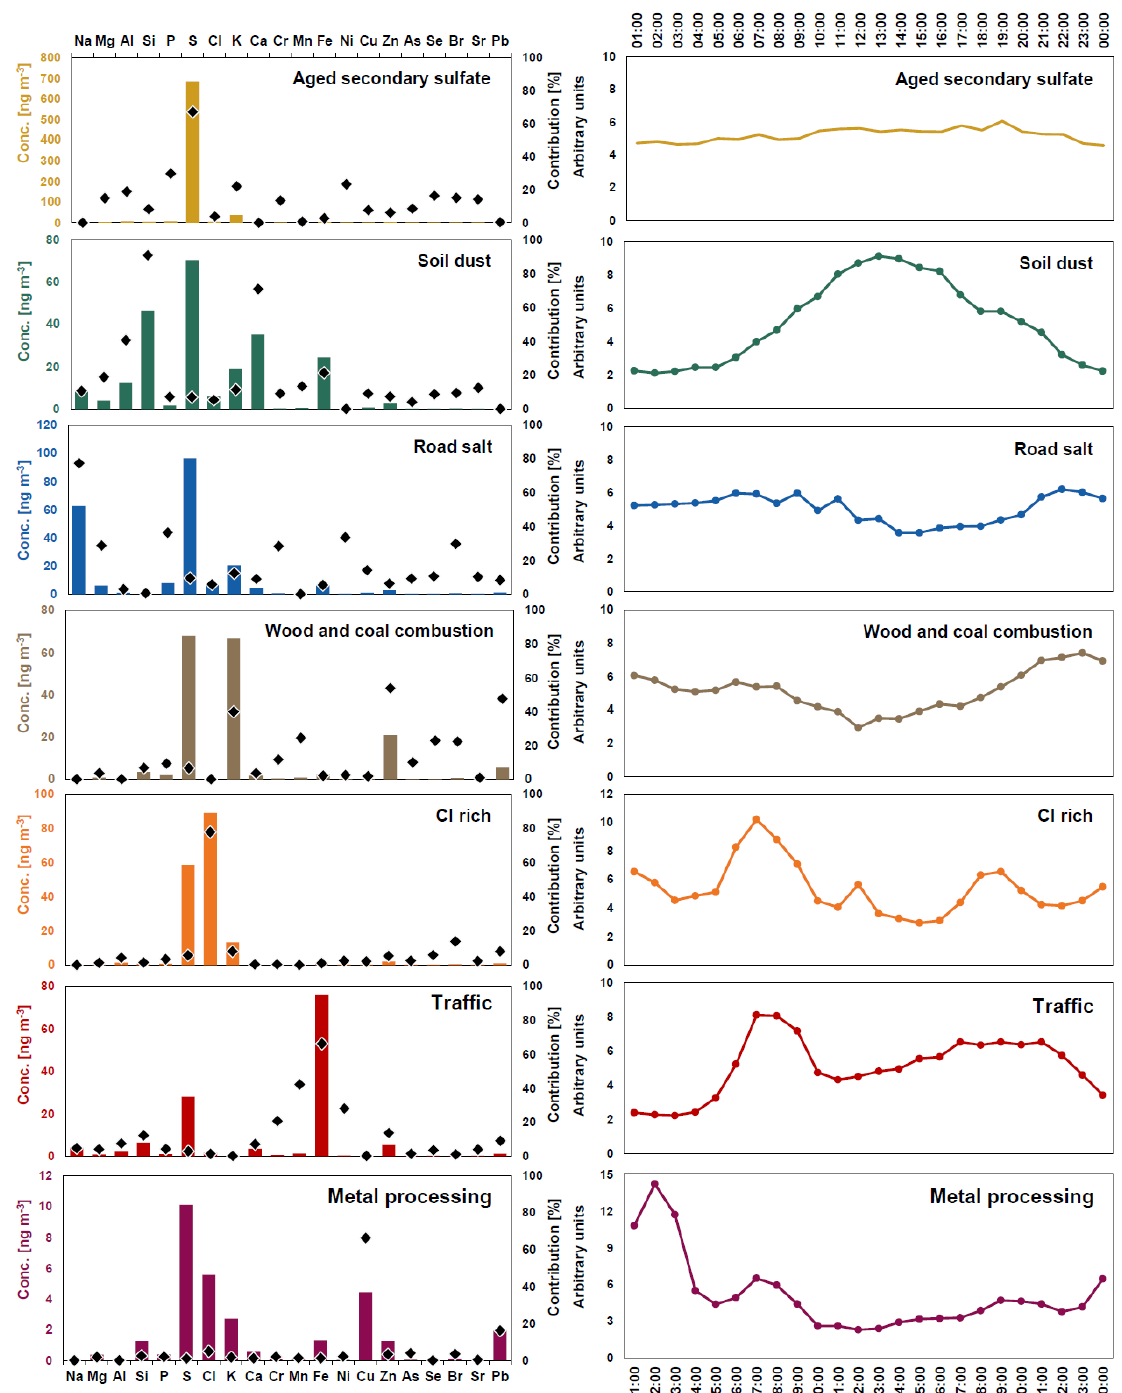
Figure 4. The left column shows the PMF profiles (bars; left y axis) and contributions (black diamonds; right y axis) of the identified sources for the fine fraction. The right column shows the daily patterns of the identified sources (in arbitrary